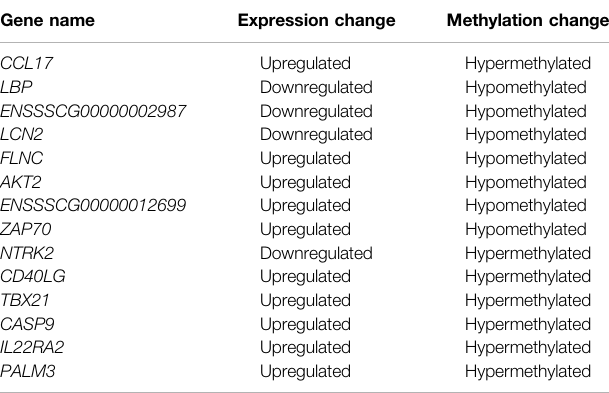
TABLE4| Listofdifferentiallymethylatedandexpressed mRNAsin C.perfringens type C infected piglets of the IR vs. IS